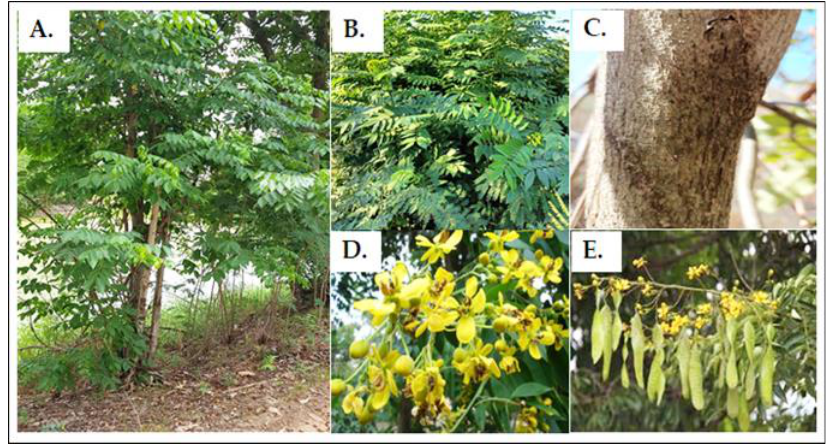
Figure 1. S. garrettiana in the natural ecosystem ( A ), the morphology of S. garrettiana leaves ( B ), trunks ( C ), flowers ( D ), and pods ( E ). Reprinted with permission from Ref. [35]. Copyright 2022, MDPI.